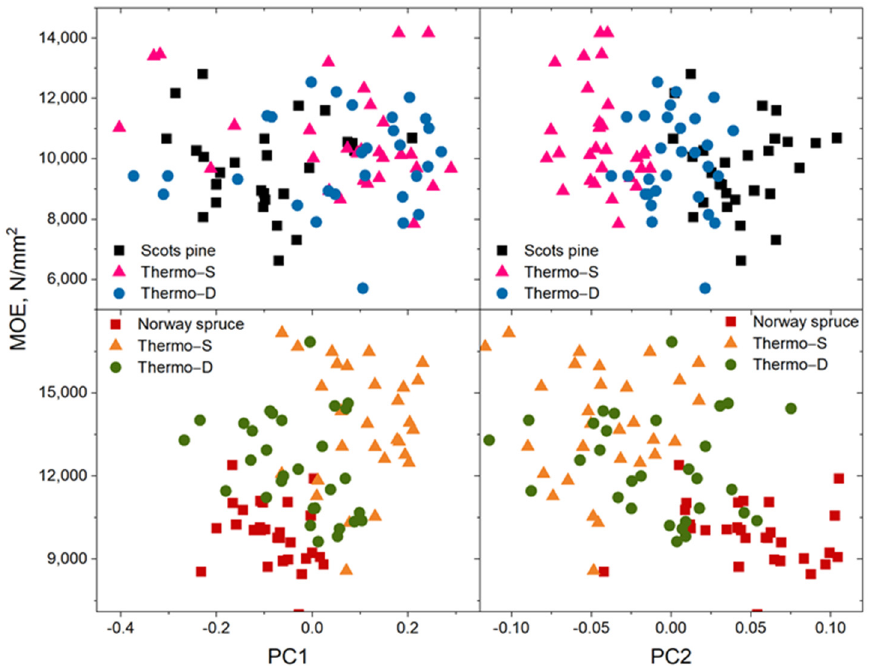
Figure 7. MOE plotted as a function of PC1 and PC2 scores for untreated and Thermo-Wood ® Norway spruce and Scots pine.